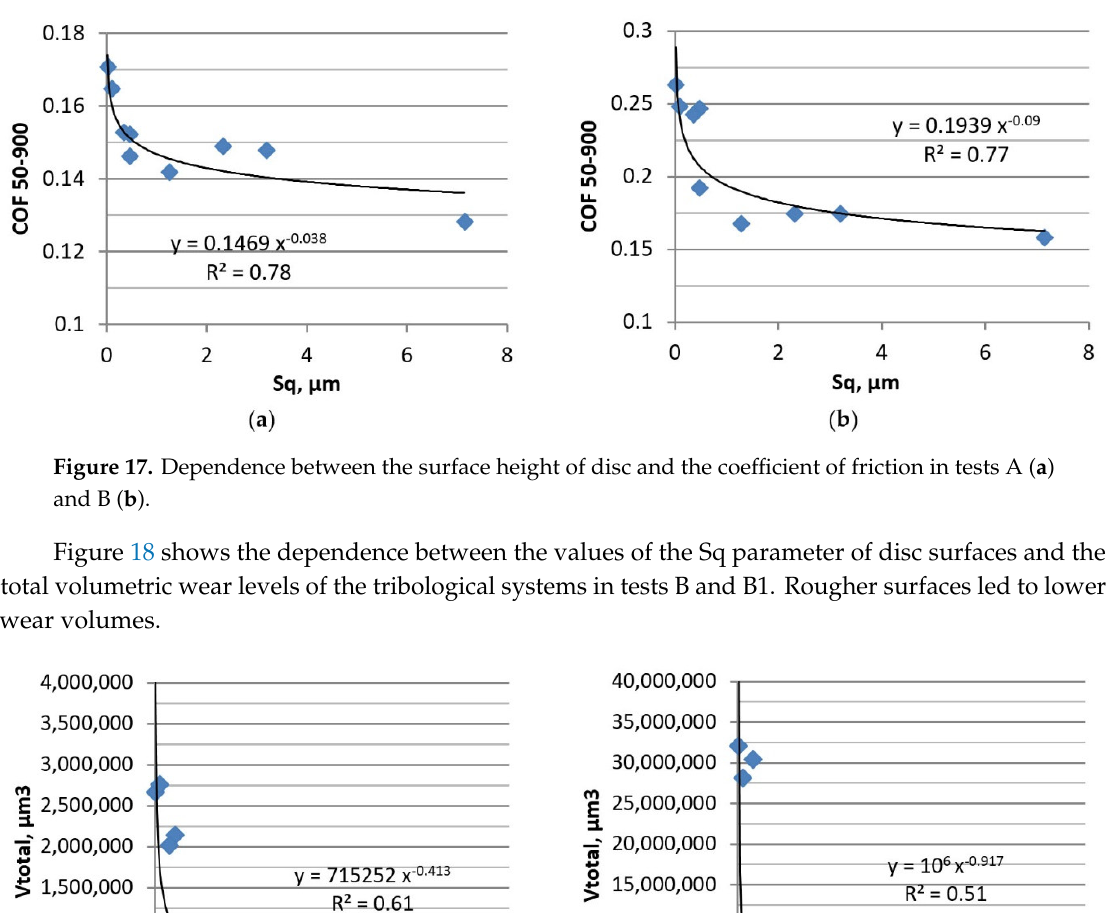
18 of 22 Figure 16. Average coefficients of friction versus volumetric wear of the tribological system in tests: B ( a ) and B1 ( b ). The different reactions of the tribological system to temperature increase in tests A and B compared to tests C and D were probably related to the various effects of disc surface topography on the friction and wear. The opinion exists that, since rough contact surface helped to retain oil, the friction and wear should be decreased. This assumption was confirmed in experimental research